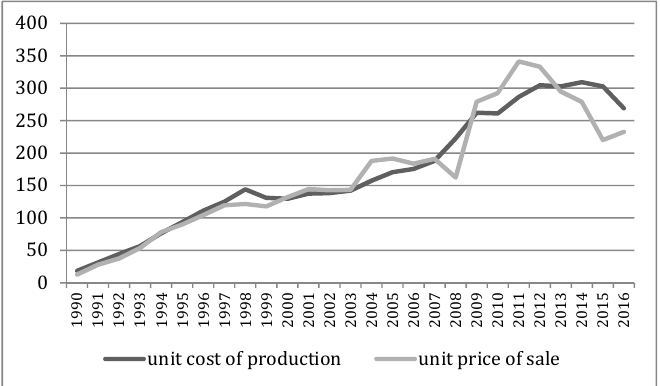
Figure 3. Unit production costs and unit sale price of hard coal in Poland in the years 1990–2016.